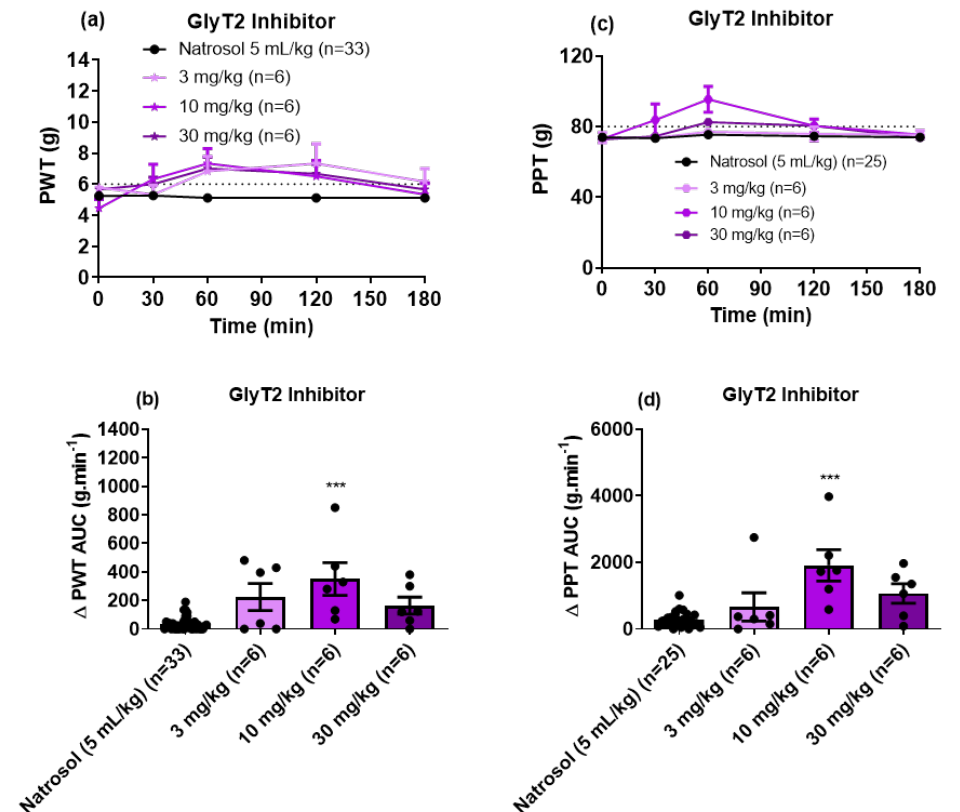
Figure 3. ( a ) Mean ( ± SEM) paw withdrawal threshold (PWT) versus time curves. ( b ) Scatter diagrams of the mean ( ± SEM) extent and duration of action quantified as the mean ( ± SEM) areas under the ∆ PWT versus time curves ( ∆ PWT AUC values) for the combined left and right hindpaws of individual CIPN-rats following the administration of single PO bolus doses of the GlyT2 Inhibitor at 3 mg/kg (n = 6), 10 mg/kg (n = 6) and 30 mg/kg (n = 6), relative to vehicle (n = 33). The horizontal dotted line in Panel ( a ) indicates fully developed mechanical allodynia in the bilateral hindpaws (PWT ≤ 6 g). ( c ) Mean ( ± SEM) paw pressure threshold (PPT) versus time curves. ( d ) Scatter diagrams of the mean ( ± SEM) extent and duration of action quantified as the mean ( ± SEM) areas under the ∆ PPT versus time curves ( ∆ PPT AUC values) for the combined left and right hindpaws of individual CIPN-rats following the administration of single oral bolus doses of the GlyT2 Inhibitor at 3 mg/kg (n = 6), 10 mg/kg (n = 6) and 30 mg/kg (n = 6) relative to vehicle (n = 25). The horizontal dotted line in Panel ( c ) indicates fully developed mechanical hyperalgesia in the bilateral hindpaws (PPT ≤ 80 g). *** p < 0.001.